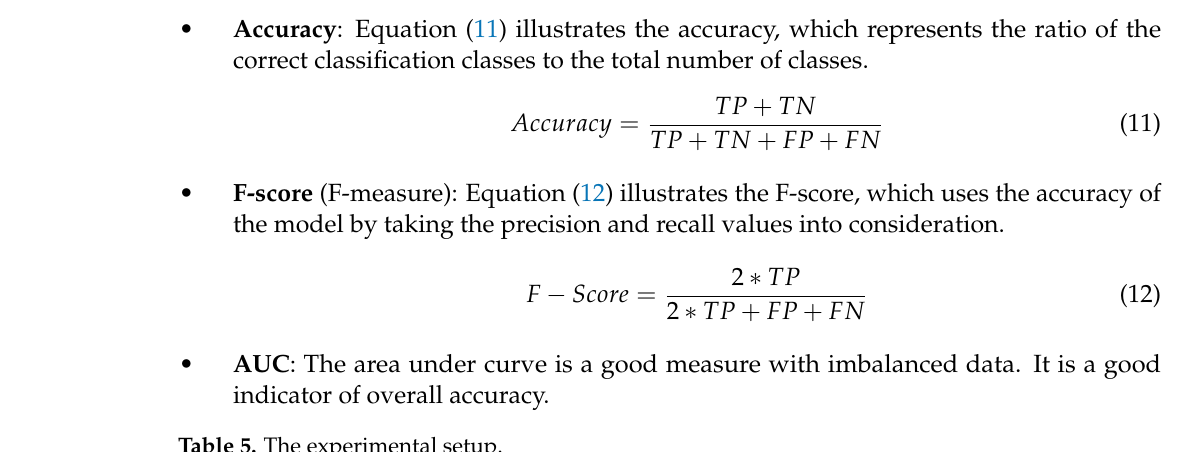
Table 5. The experimental